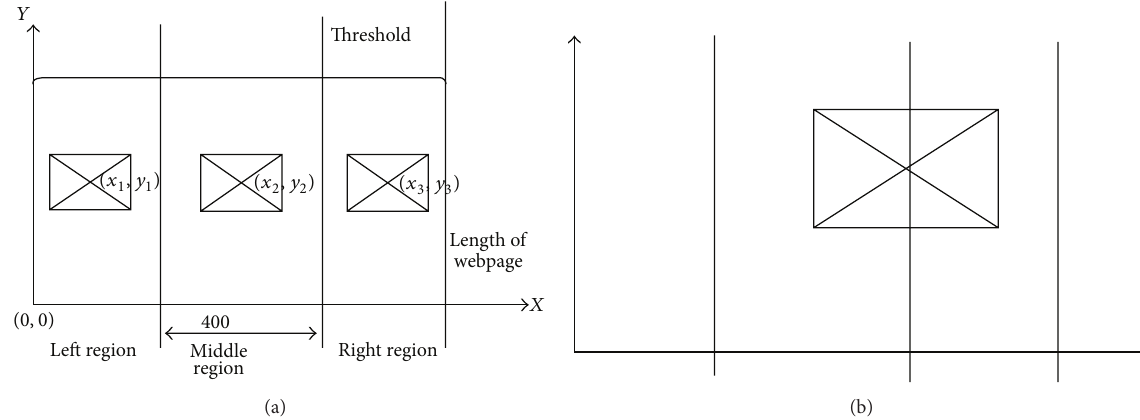
Figure 9: The partitioning of the screen into the three regions. In (a), three objects are shown as examples of object positions. Note that in this work, we assume an object lies entirely in a region. Thus situations such as the one shown in (b), where objects overlap two or more regions, are not